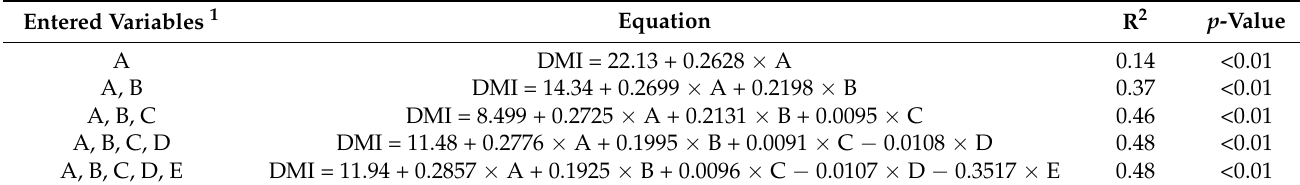
Table 3. R 2 change with entered more independent variables gradually by stepwise regression.